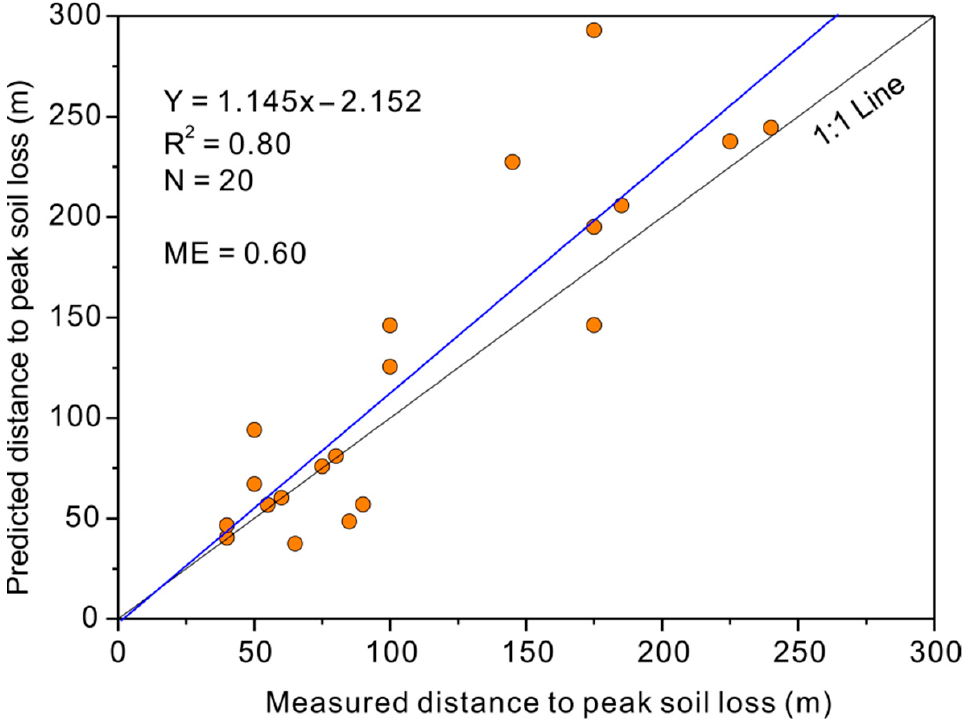
Figure 5. The measured distance to the peak soil loss as plotted with the predicted values. Table 4. The correlation coefficient between model deviation and influential factors. Road Upstream Length Slope Tortuosity